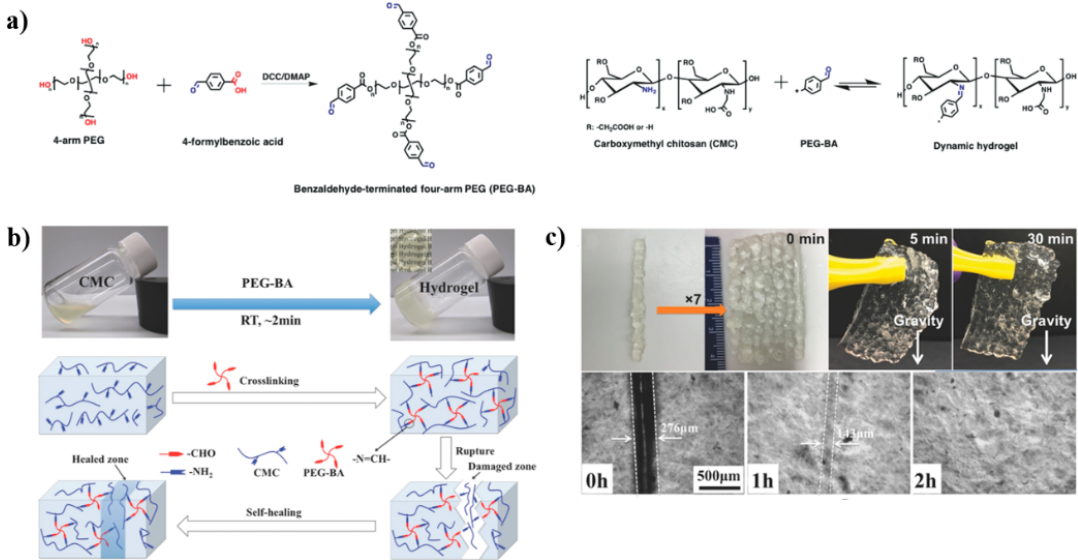
Figure 3. ( a ) the synthesis scheme of benzaldehyde-terminated four-arm PEG (PEG-BA), and PEG-BA conjugated amino group of CMC to form dynamic hydrogel; ( b ) schematic illustration of the gelation and self-healing process; ( c ) macroscopic self-healing process of the hydrogel. Top : the hydrogel strips extruded from syringe and healed to a whole piece and suspended under gravity; bottom : optical microscope images of hydrogels after healing for 0, 1, and 2 h at room temperature. Reprinted with permission [36]. Copyright 2016, Wiley-VCH.